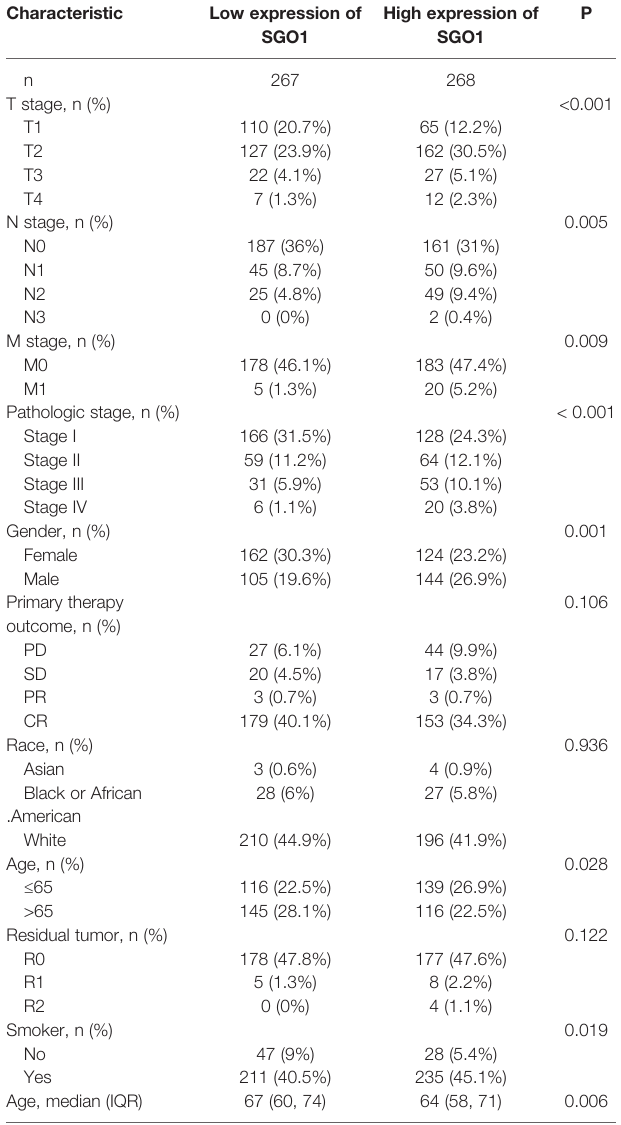
TABLE 1 | Clinical characteristics of the LUAD patients. Characteristic Low expression of